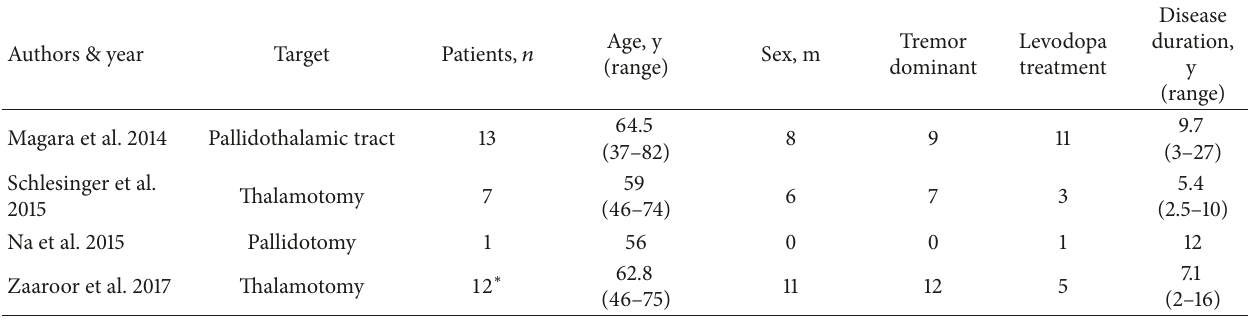
Table 1: Characteristics of Parkinson’s disease patients that underwent MRgFUS treatment.